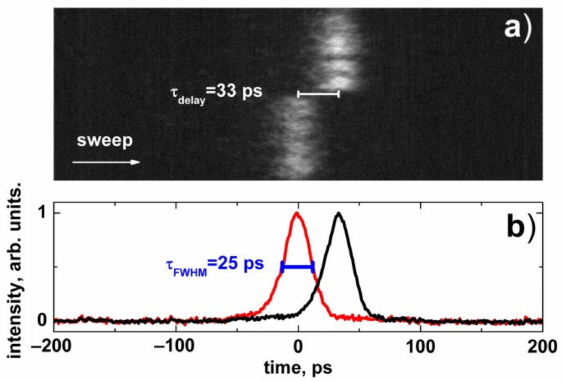
Figure 9. Measurement of the pulse duration using streak camera: ( a ) Signal at streak camera output, 33 ps time delay is due to a calibrate quartz plate in the upper half of the laser beam; ( b ) Pulse duration determined on the basis of the densitogram, taking into account the calibration from ( a